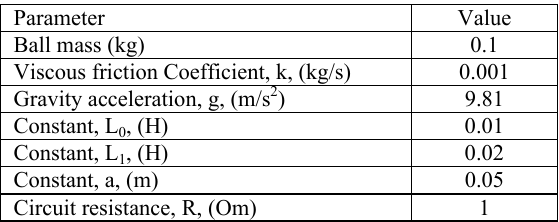
Table 1: Mechanical and Electrical System